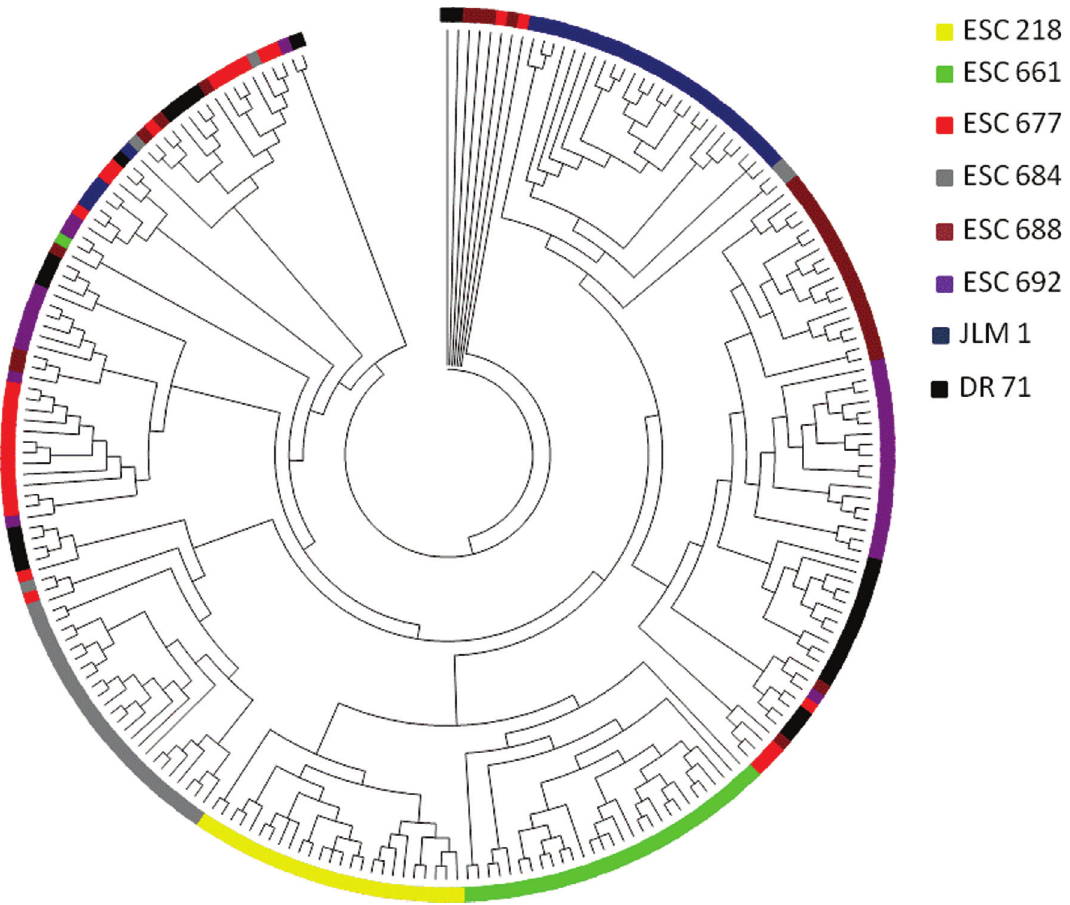
Figure 3 - Unweighted pair-group method arithmetic average (UPGMA) dendrogram based on Jaccard’s index showing genetic similarity among all pairs of individuals of Calydorea crocoides .